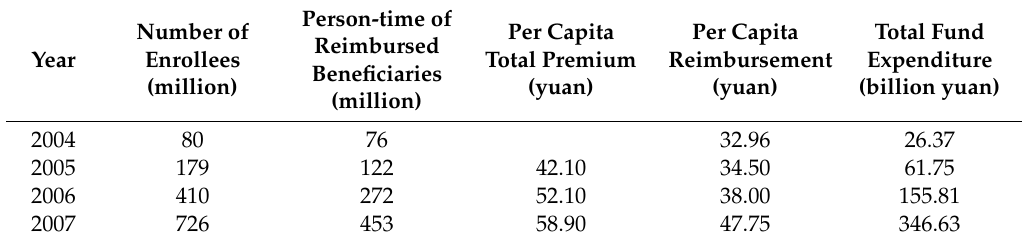
Table 1. The Reimbursement of the New Cooperative Medical Scheme